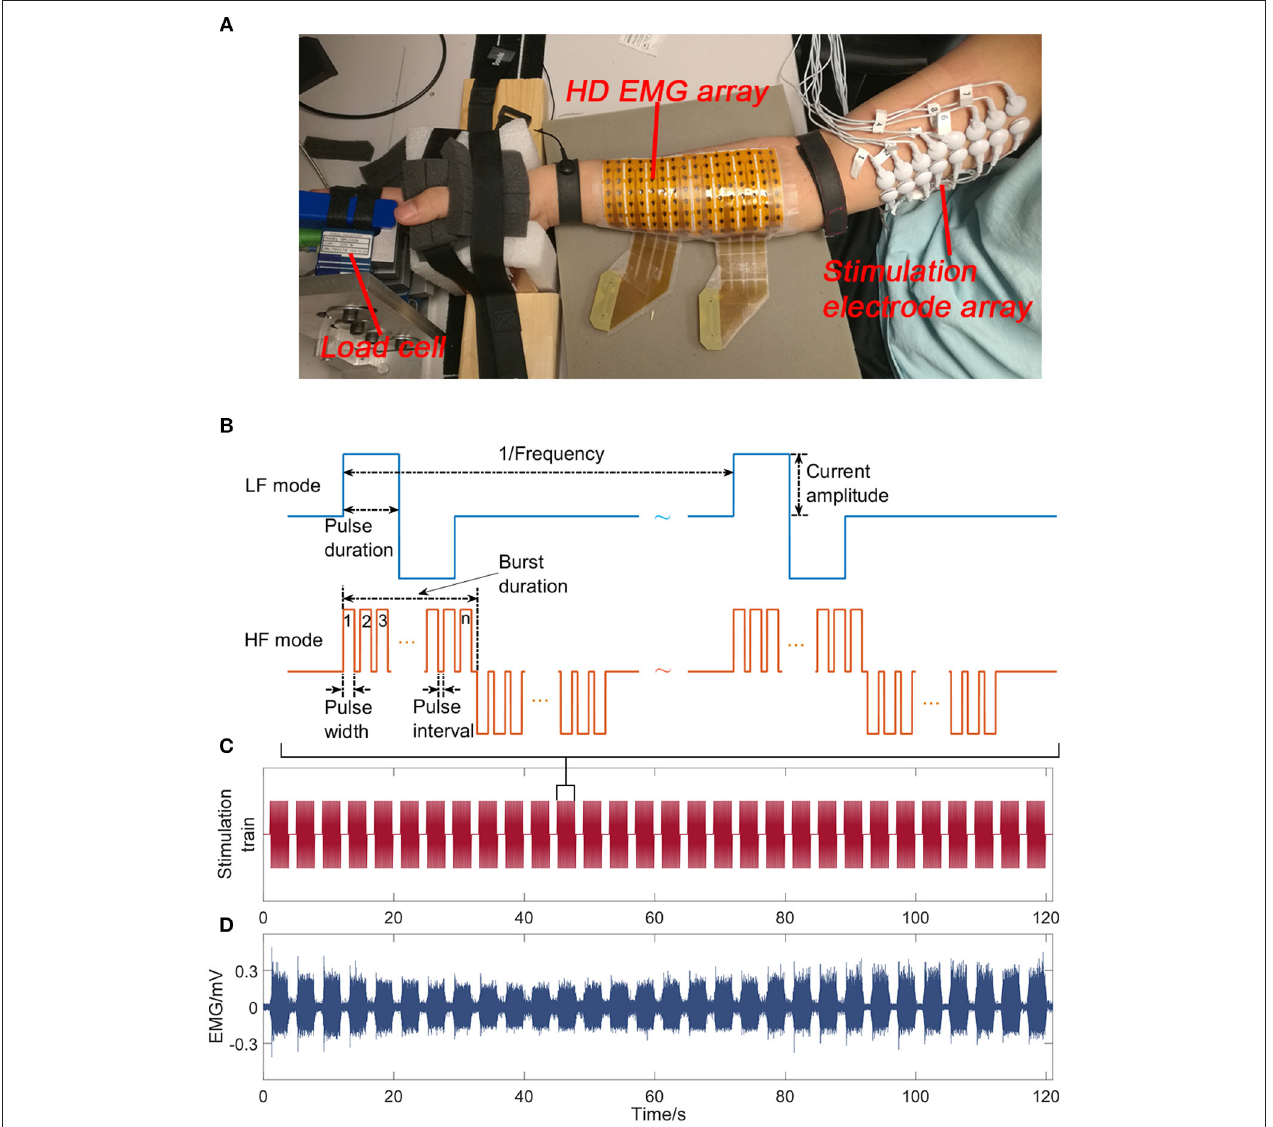
FIGURE 1 | The experimental apparatus includes the stimulation of the ulnar/median nerve bundles, and the recordings of high density EMG at the forearm flexor muscles and the finger flexion forces (A) . Sample stimulation trains for the LF and HF stimulation mode (B) . The stimulation train of a trial on the contralateral side in the HF mode (C) . The EMG signal of a representative channel recorded on the contralateral side in the HF mode (D)